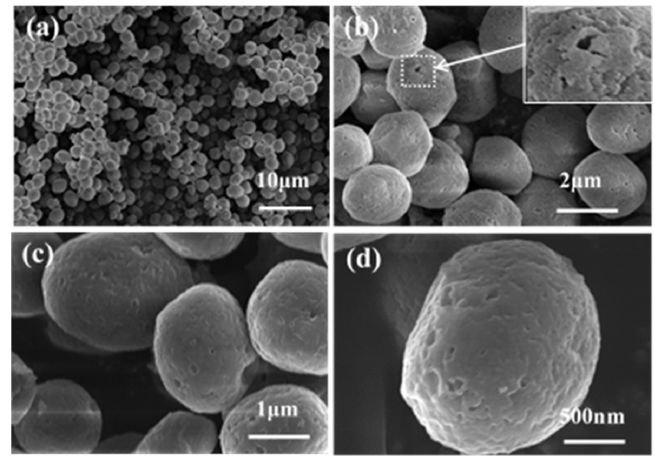
Figure 1. FE ‐ SEM images of α‐ Fe 2 O 3 @PHCMs under different magnifications. Figure 1. FE-SEM images of α -Fe 2 O 3 @PHCMs under different